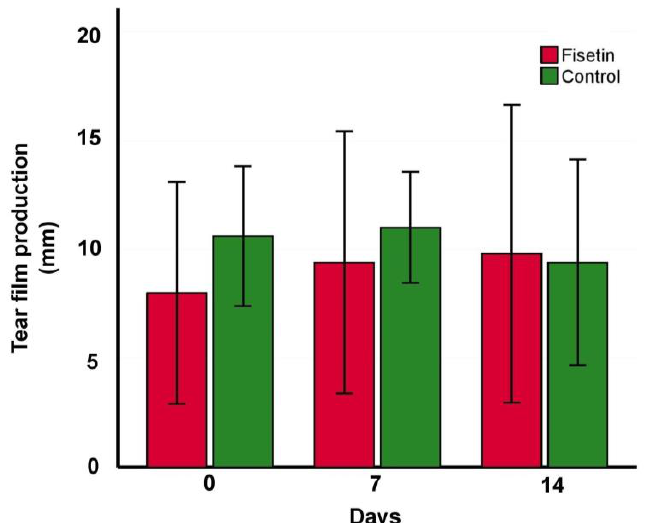
Figure 3. Mean change in tear film production over the treatment period in fisetin (red) and control (green) groups. Statistical significance was tested using an unpaired two-sided t -test.